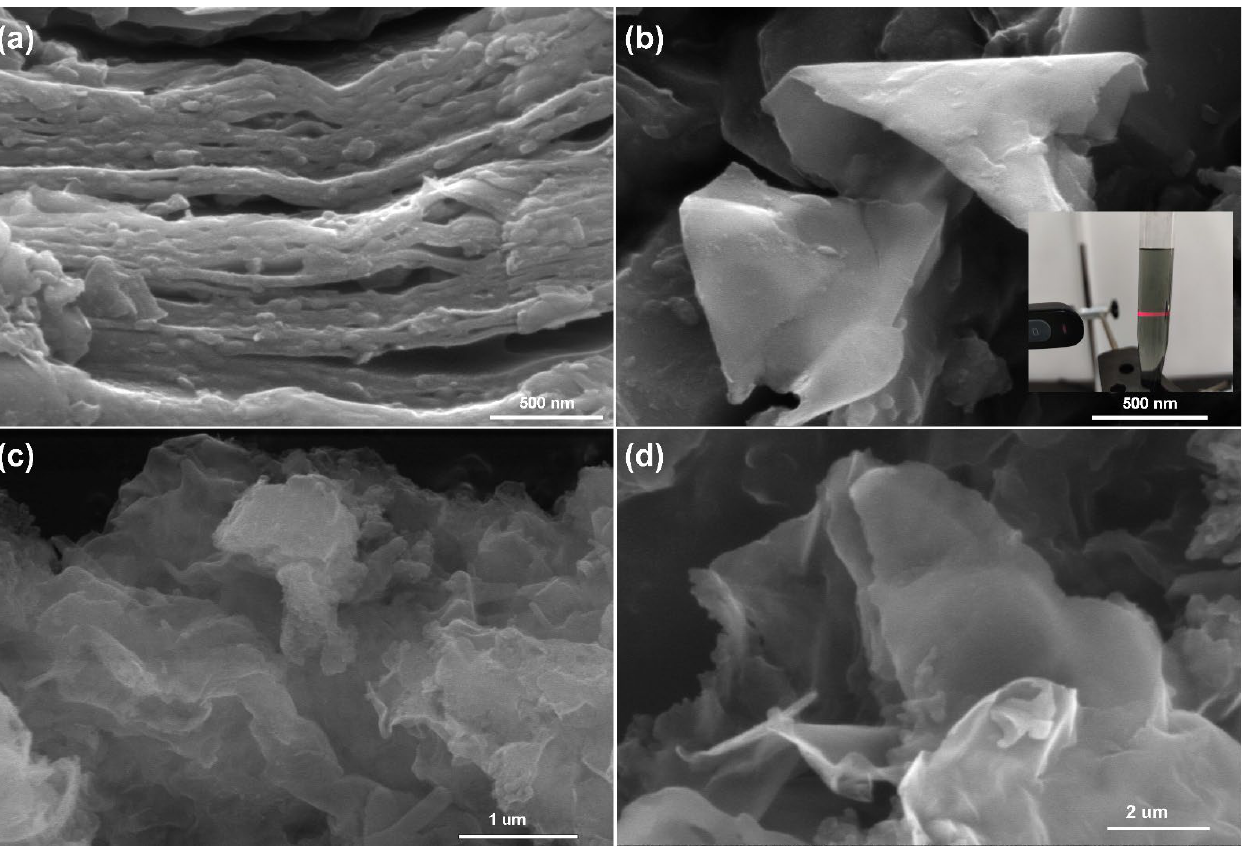
Figure 1. FESEM images of ( a ): multilayer Ti 3 C 2 MXene, ( b ): monolayer Ti 3 C 2 MXene and the Tyndall effect in illustration, ( c ): sheet g − C 3 N 4 , and ( d ): 2 − TC/CN.